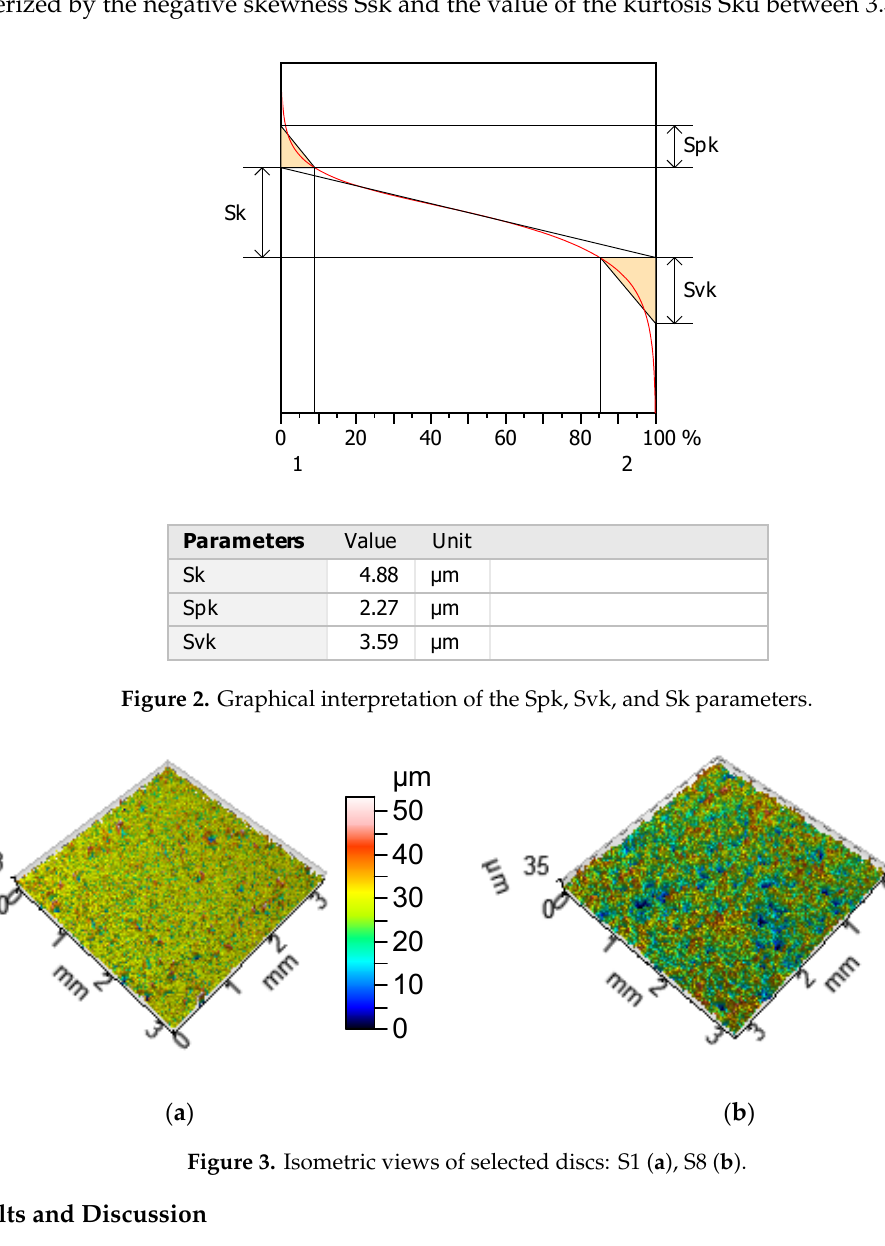
Figure 3. Isometric views of selected discs: S1 ( a ), S8 ( b ).